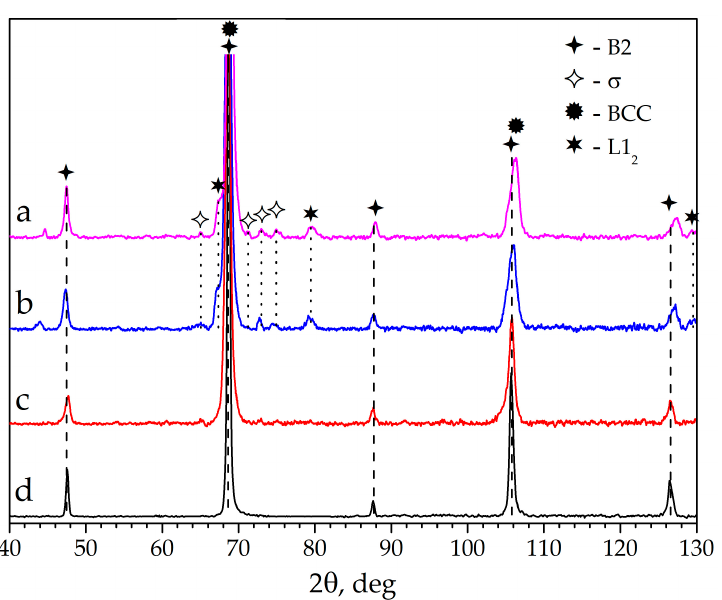
Figure 5. X-ray diffraction data for the sintered samples: CS+SPS at 800 ( a ) and 1000 °C ( c ), RSPS at 800 ( b ) and 1000 °C ( d ). Table 4. Phase composition of bulk materials after CS+SPS and RSPS, depending on the tempera- ture.